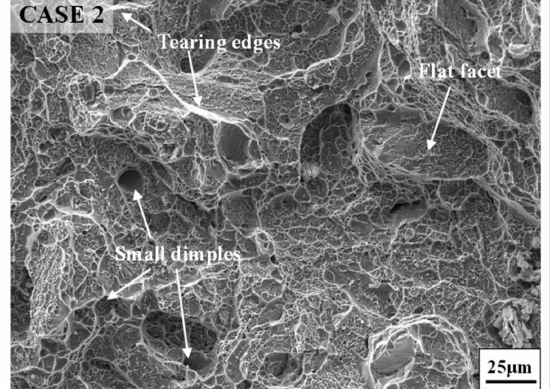
Figure 12. Fracture morphology of the studied superalloy with single annealing